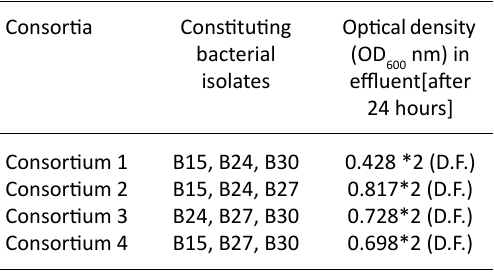
Table 4. Bacterial consortia composition and their growth in effluent Consortia Constituting